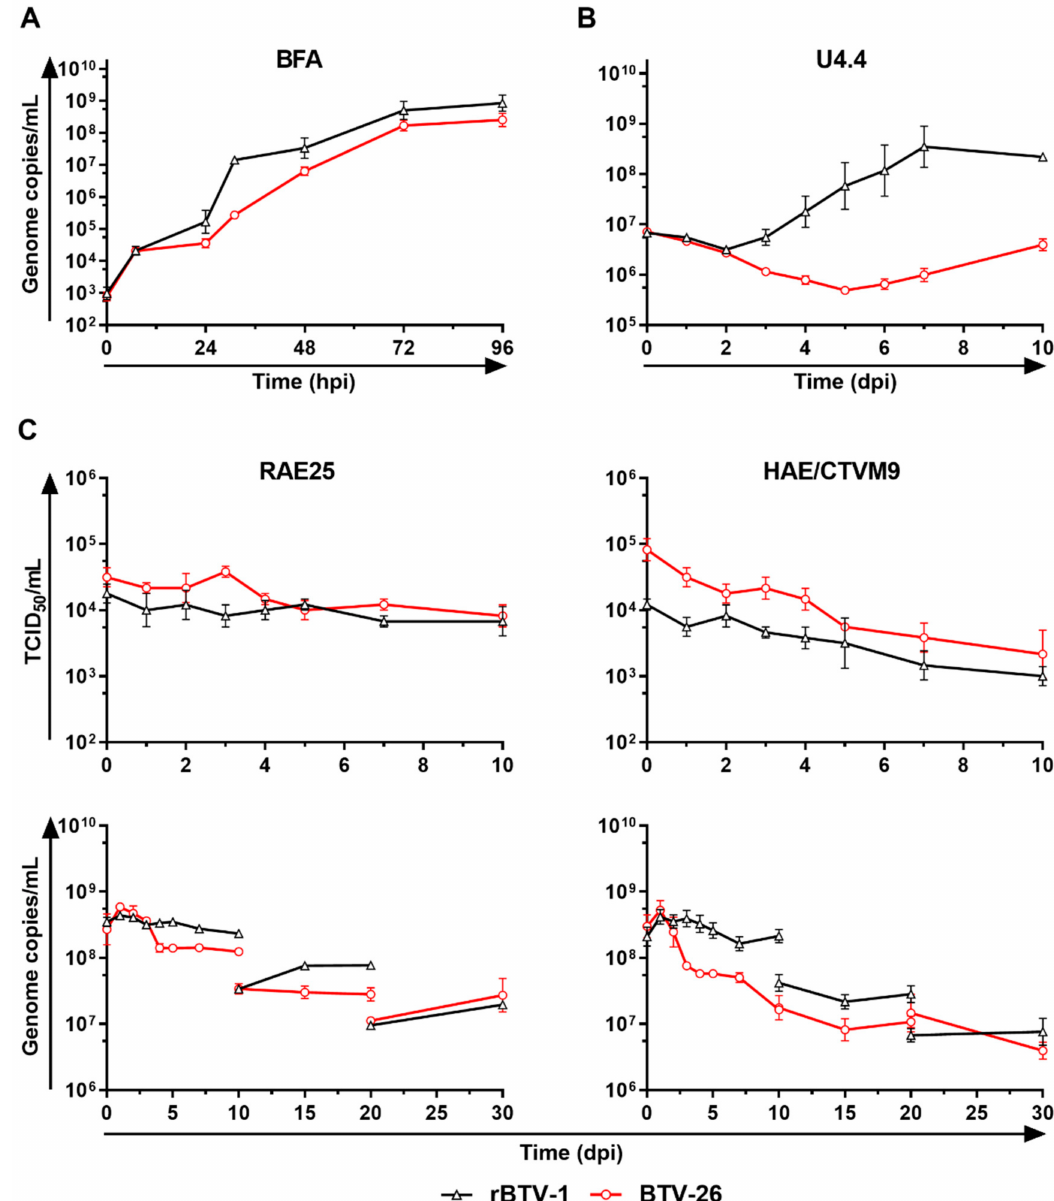
Figure 1. Replication kinetics of BTV-1 and BTV-26 in mammalian and arthropod cell lines. Bovine-BFA cells ( A ) were seeded at a density of 1.00 × 10 5 cells/well. Aedes -U4.4 cells ( B ) were seeded at a density of 2.50 × 10 7 cells/flask. In ( C ), tick-derived Rhipicephalus appendiculatus -RAE25 cells or Hyalomma anatolicum -HAE/CTVM9 cells were seeded at a density of 2.40 × 10 6 cells/tube or 2.00 × 10 6 cells/tube, respectively. Cells were infected at a MOI of 0.01 ( A , B ) or 1 ( C ) with rBTV-1 (black triangles) or BTV-26 (red circles). Infected BFA cells were incubated at +37 ◦ C with CO 2 , while U4.4 were incubated at +28 ◦ C without CO 2 and tick cells at +32 ◦ C without CO 2 . In all panels, 250 µ L of supernatant were collected at each indicated time point. BTV genome copy numbers were determined using the qRT-PCR BTV Seg-9 assay [50] on extracted RNA and the results are expressed as the mean of genome copies/mL of two independent experiments ( A , B ) or one experiment in triplicate ( C ) ± standard error of the mean. In ( C ), 50 µ L of supernatant were used to calculate 50% tissue culture infective dose (TCID 50 /mL) in BSR